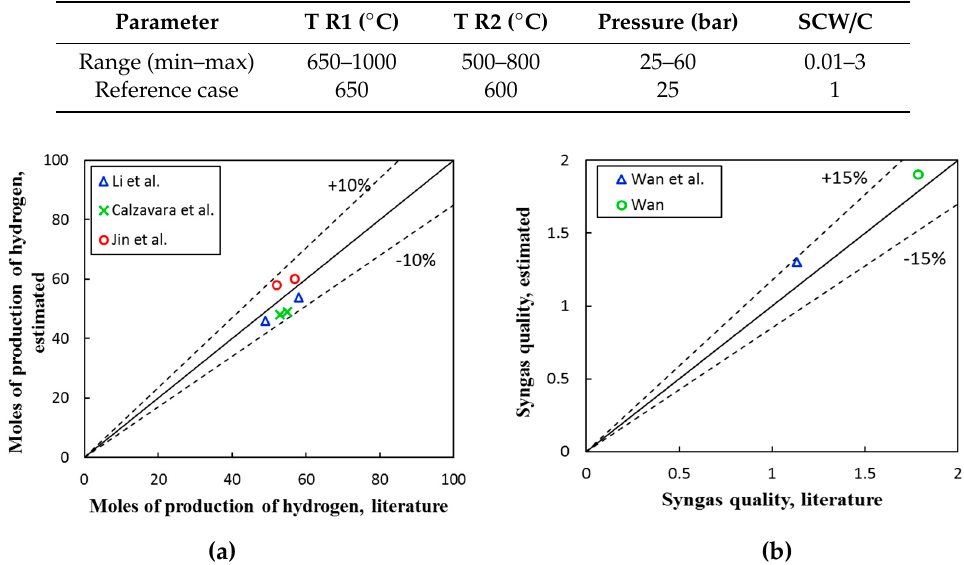
Figure 3. Validation of the model using the data reported in the literature, (a) comparison between estimated moles of production of hydrogen and data reported in previous works [48–50], (b) comparison between the estimated syngas quality (H 2 :CO molar ratio) and those reported in the literature [51,52].